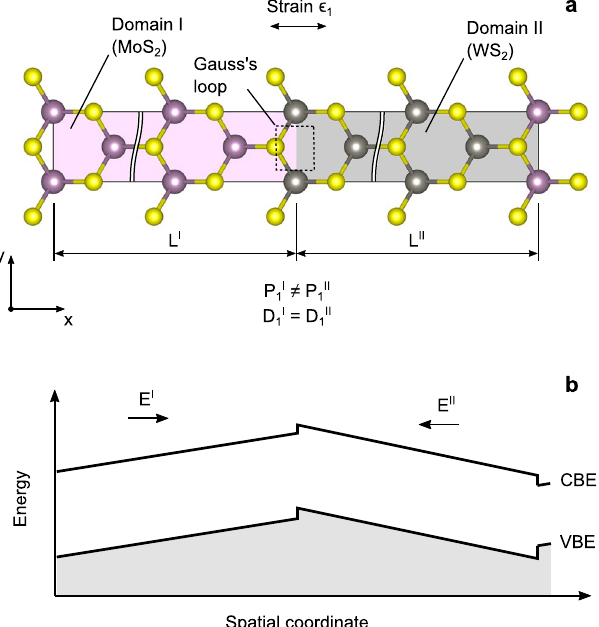
Figure 3. Continuum model of lateral MoS 2 /WS 2 heterointerface. ( a ) The strain along x -axis induces a heterogeneity of electronic polarisation P due to differences in the piezoelectric response between two materials. ( b ) Inhomogeneities in polarisation create regions with an opposite electric field E that results in subsequent spatial bending of the conduction band minima (CBM) and valence maxima